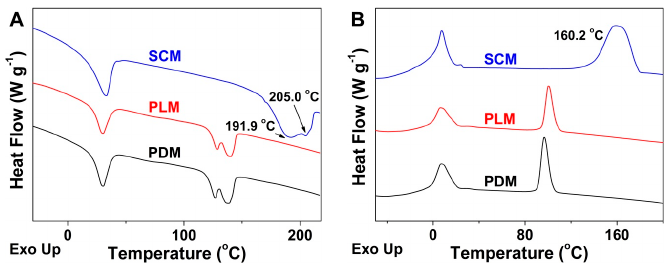
Figure 4. DSC thermal graphs of PDM, PLM, and SCM during heating ( A ) and cooling processes ( B ).